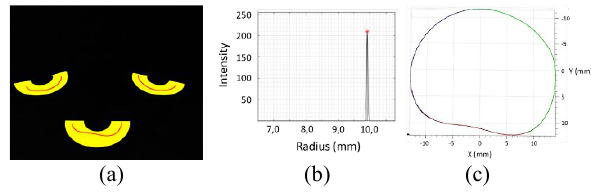
Figure 6: (a) 3D point cloud projected in a real image space (yellow) and detected peaks (red), (b) peak detection for a radial direction, and (c) a reconstructed section of a real object with a single image, with red points for the front view and blue and green points for mirrored views.